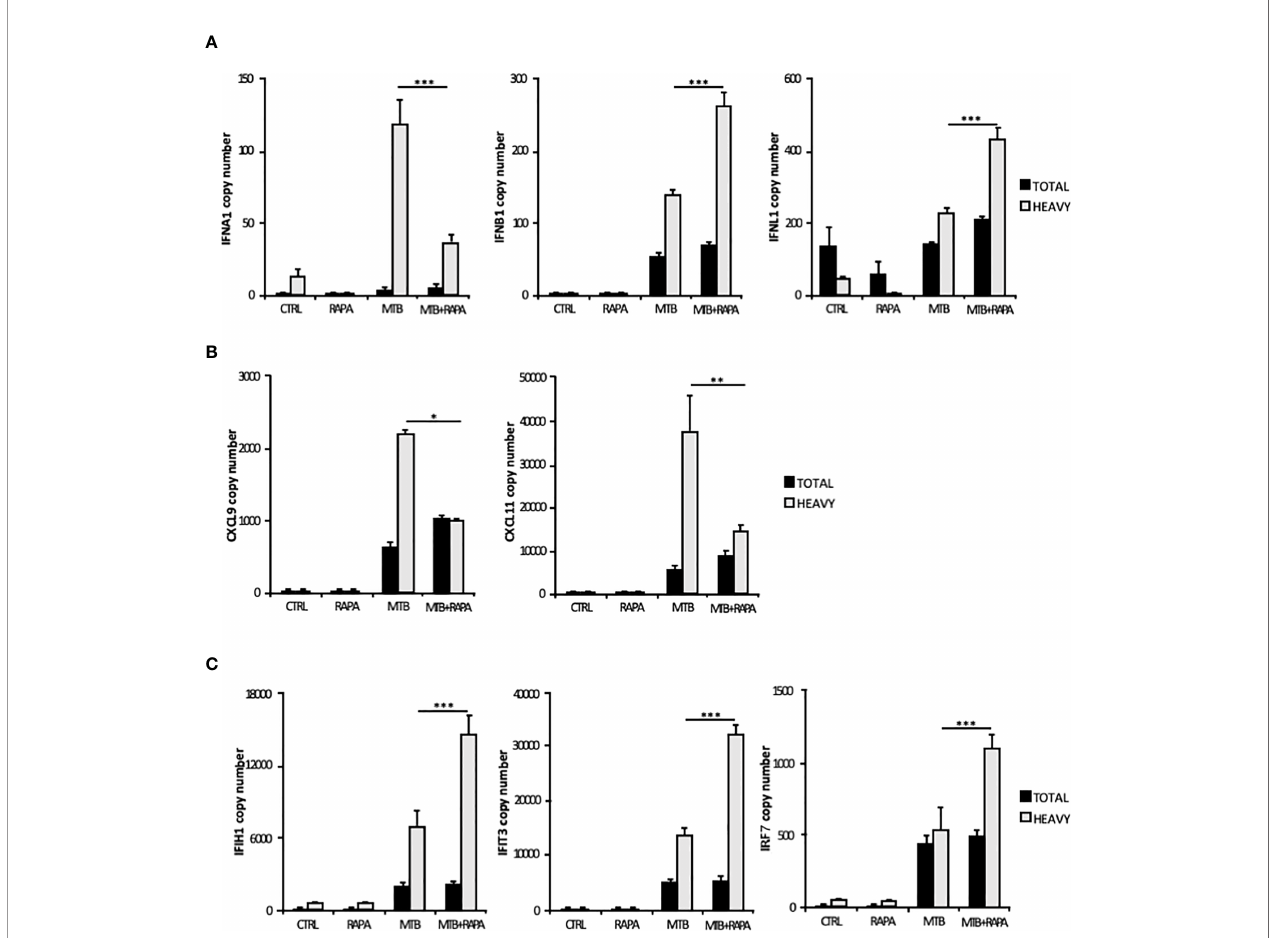
FIGURE 4 | Validation of translatome data on IFNs and IFN-induced gene expression. Total RNA (Total) and high occupancy (Heavy) polysome-associated mRNAs were extracted from untreated DC (CTRL), DC stimulated with rapamycin for 12 h (RAPA) or DC infected for 16 h with Mtb alone (MTB) or in combination with rapamycin (MTB+RAPA, added 4 h after infection). (A) IFNA1 , IFNB1 and IFNL1 , (B) CXCL9 and CXCL11 , (C) IFIH1 , IFIT3 and IRF7 copy numbers were determined by digital PCR. Data are represented as the mean copy number per sample ± standard error of 4 experiments performed with RNAs derived from a set of experiments independent than those used in transcriptome/translatome studies and that yielded similar results. Signi fi cance was calculated by analysis of variance (ANOVA) followed by multiple comparison performed with Tukey ’ s test as speci fi ed in Materials and Methods